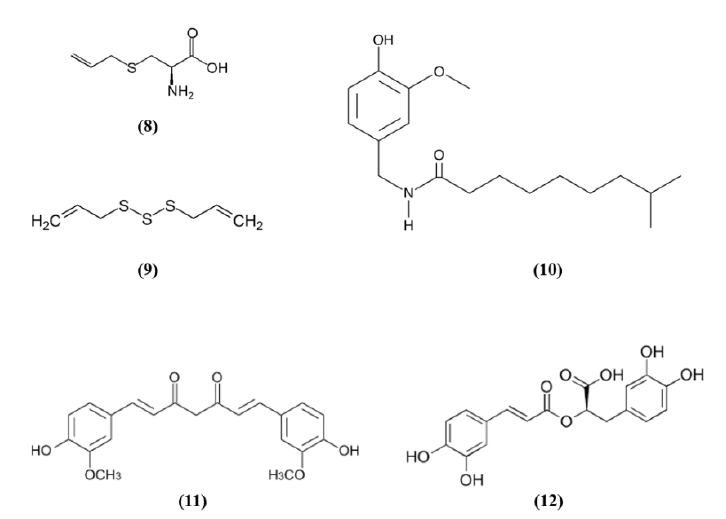
Figure 3. Chemical structure of ( 8 ) S-allyl cysteine, ( 9 ) diallyl trisulfide, ( 10 ) dihydrocapsaicin, ( 11 ) curcumin, and ( 12 ) rosmarinic acid.